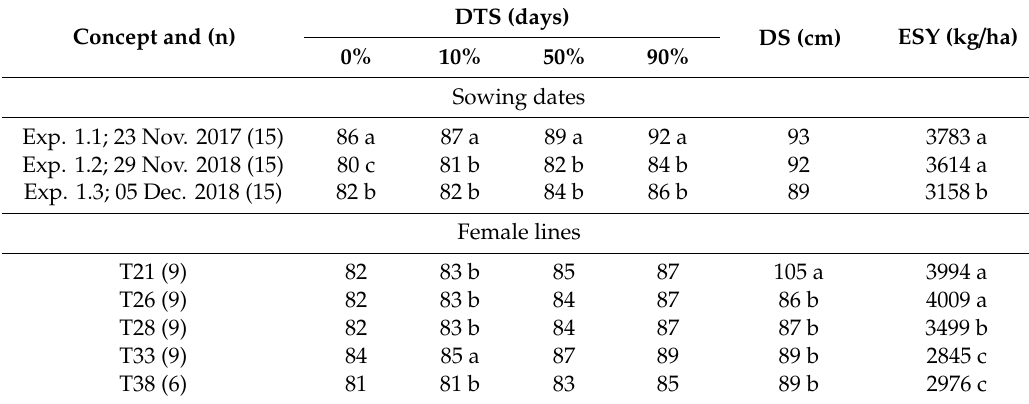
Table 6. Means by sowing dates of female lines in Experiment